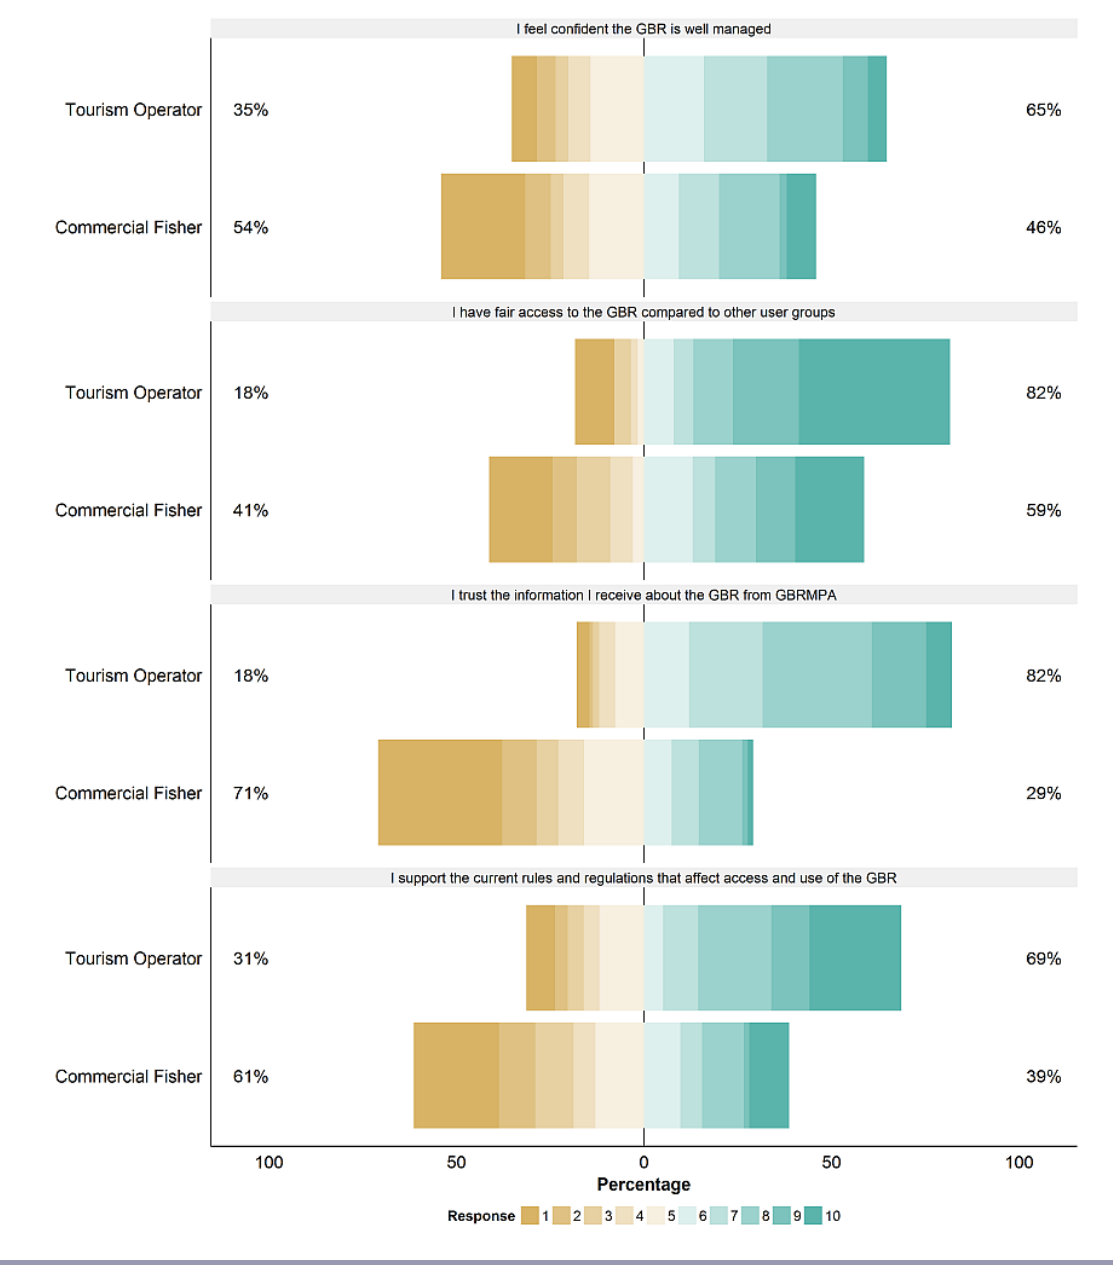
Fig. 2. Support for rules and regulations and indicators of perceived legitimacy by two key user groups of the Great Barrier Reef Marine Park. Shading represents the proportion of respondents choosing each score on a 10- point ordinal scale (1 = very strongly disagree, 10 = very strongly agree). GBR = Great Barrier Reef, GBRMPA = Great Barrier Marine Park